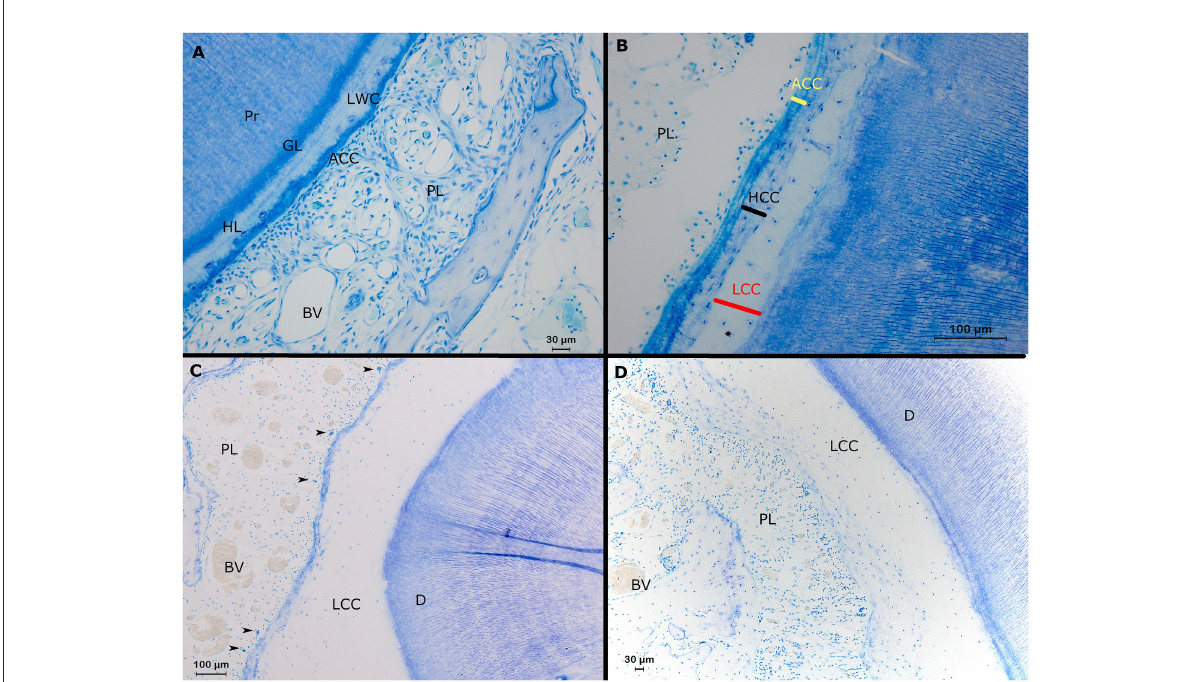
FIGURE6 Histological representation of perceivable structures at the root level in alpaca cheek teeth. (A) Transverse decalcified histological section of a second molar in the right upper jaw (19mm subocclusal) in a 4 years and 3 months old alpaca (dental age 2 years and 6 months). Adjacent to the primary dentin (Pr), the dentinocemental junction features a regular stratigraphic organization composed of a so-called granular layer of Tomes (GL) and a so-called hyalin layer of Hopewell Smith (HL). The dentinal tubules near the dentinocemental junction are organized in a parallel lining and show a typical branching. The dental cementum is composed of a layer of low cellular cementum (LWC) adjacent to the hyaline layer of Hopewell Smith. In this section, a small layer of acellular cementum (ACC) is visible in-between the low cellular cementum and the periodontal ligament (PL) with blood vessels (BV; Toluidin, 20x magnification). (B) Transverse section of a first molar in the left lower jaw in a 3-years-old animal (dental age 2 years and 4 months) showing the 3 different types of cementum at the level of alpaca cheek teeth. At the level of the dentinocemental junction, low cellular cementum can be found (LCC). Adjacent, more peripherally, a high cellular cementum (HCC) layer can be found. A layer of acellular cementum (ACC) forms a connection with the periodontal ligament (PL; Toluidin, 20x magnification). (C,D) Transverse sections originating from the same first premolar in the upper left jaw in a 3-years-old animal (dental age 2 years and 4 months; Toluidin, 10x magnification). (C) Buccodistal border of root I. A thick layer of low cellular cementum is present (LCC) adjacent to the dentin (D). Cell rests of Malassez are indicated by black arrows. Inside the periodontal ligament (PL), large blood vessels (BV) are visible. (D) Interradicular region of root 1 with only an extensive layer of low cellular cementum (LCC) connecting the dentin (D) and the periodontal ligament (PL). Some large blood vessels are visible within the periodontal